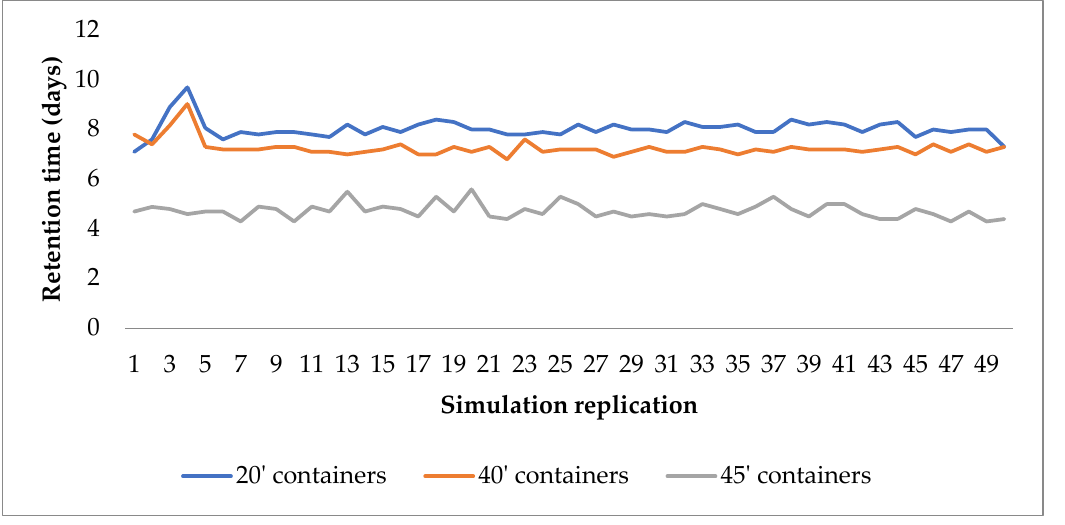
Figure 6. Simulated container retention times as a function of simulation replication. The simulated average number of inbound containers in simulation replications was